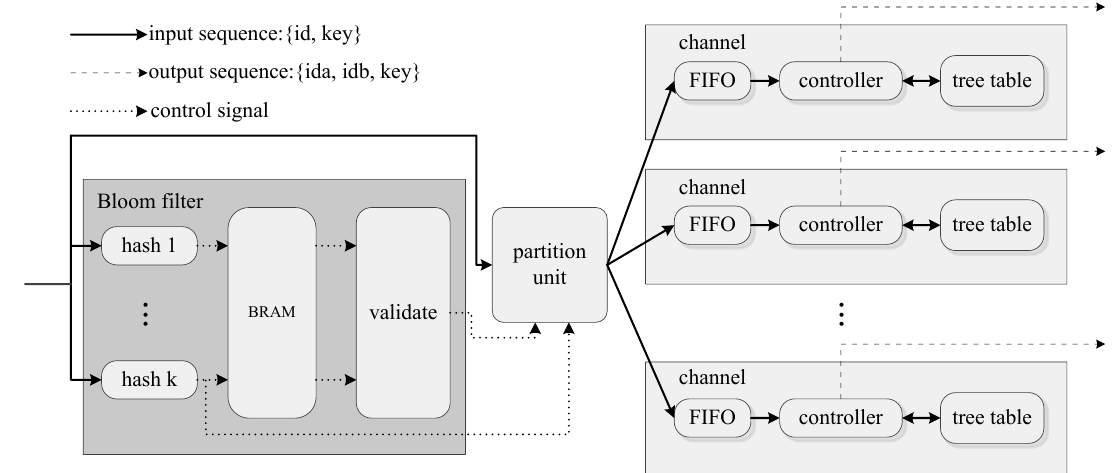
Figure 3. An example of the binary tree model.